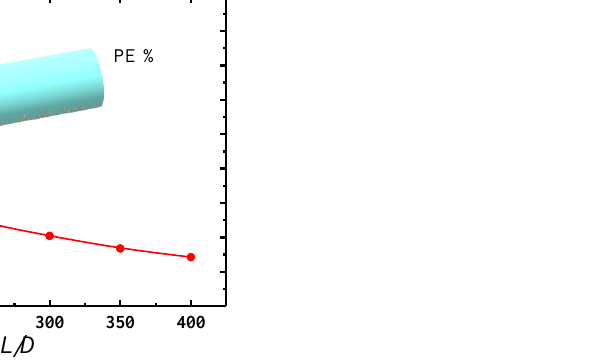
Figure 12. Penetration efficiency as a function of pipe length-to-diameter ratio (Re = 20,000, λ = 8).